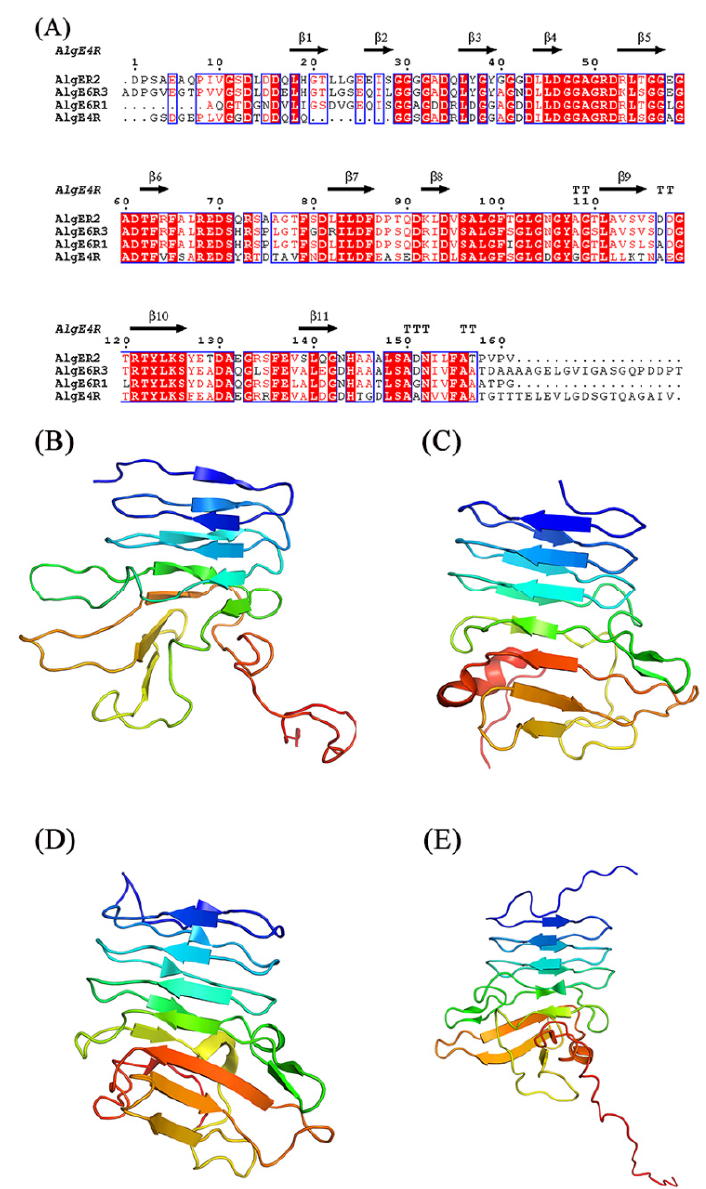
Figure 3. Sequence alignment and structures of R-modules of AvAlgE4 and AvAlgE6. ( A ) Alignment of the R-modules of AvAlgE4 and AvAlgE6. The beta strands are represented as arrows and beta turns are marked with TT. The sequence alignment was created using the following sequences from PDB: AvAlgE4R (2AGM), AvAlgE6R1 (2ML1), AvAlgE6R2 (2ML2), and AvAlgE6R3 (2ML3). The figure was created with ESPript 3.0 [93]. ( B ) Overall structure of AvAlgE4R. ( C ) Overall structure of AvAlgE6R1. ( D ) Overall structure of AvAlgE6R2. ( E ) Overall structure of AvAlgE6R3 [69,85,86]. The figures were produced using